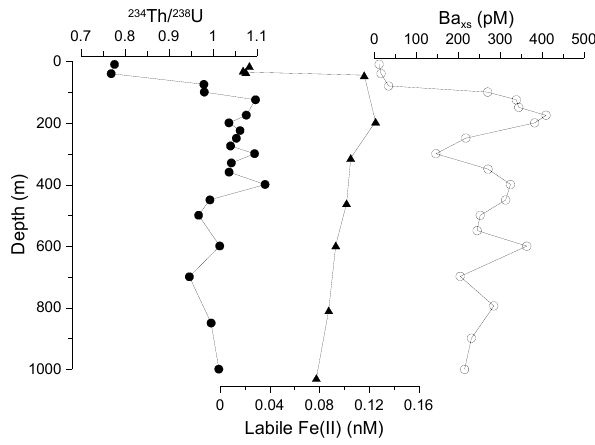
Fig. 7. Vertical profiles of 234 Th/ 238 U, labile Fe(II) and Baxs at station S2. Baxs is the biogenic particulate Ba calculated by sub- tracting the lithogenic Ba from total particulate Ba.